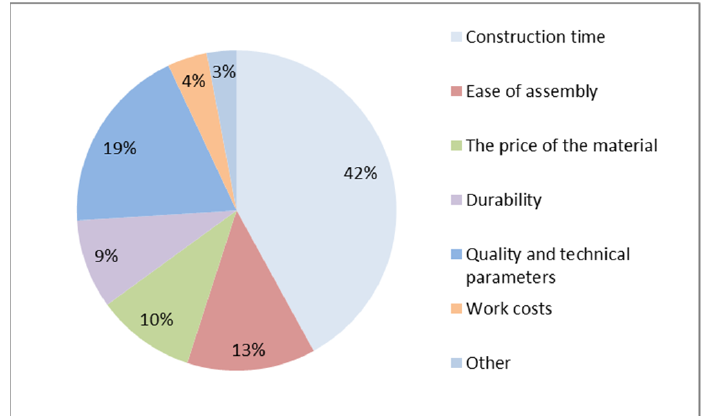
Figure 3. The most important factor when choosing the technology of precast concrete elements in the opinion of investors.